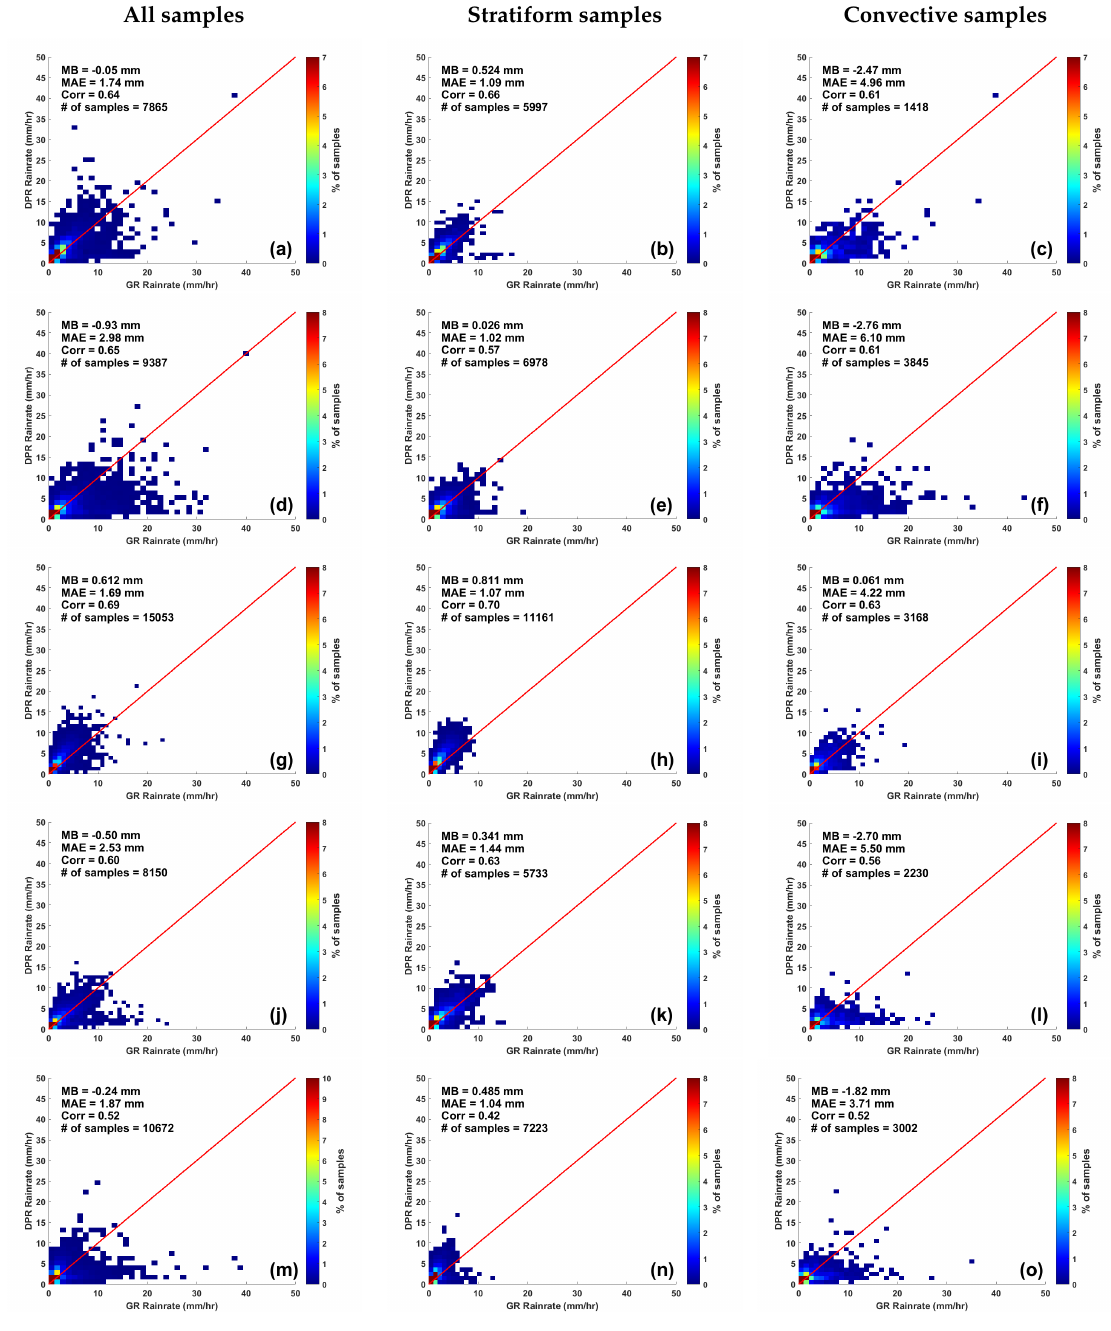
Figure 8. Same as Figure 7 but for GPM-DPR dual-frequency product. Table 3. Table summarizing different error statistics for comparison of DPR single and dual-frequency rainfall rate product vs NEXRAD dual-pol